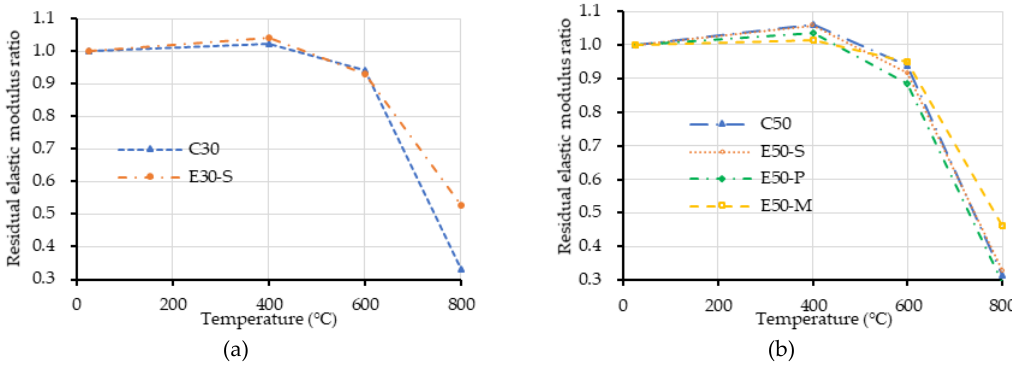
Figure 9. Comparison of residual elastic modulus ratio of LWC specimens: ( a ) low- and ( b ) Comparison of residual elastic modulus ratio of LWC specimens: ( a ) low- and medium-strength concrete. ( b ) medium-strength